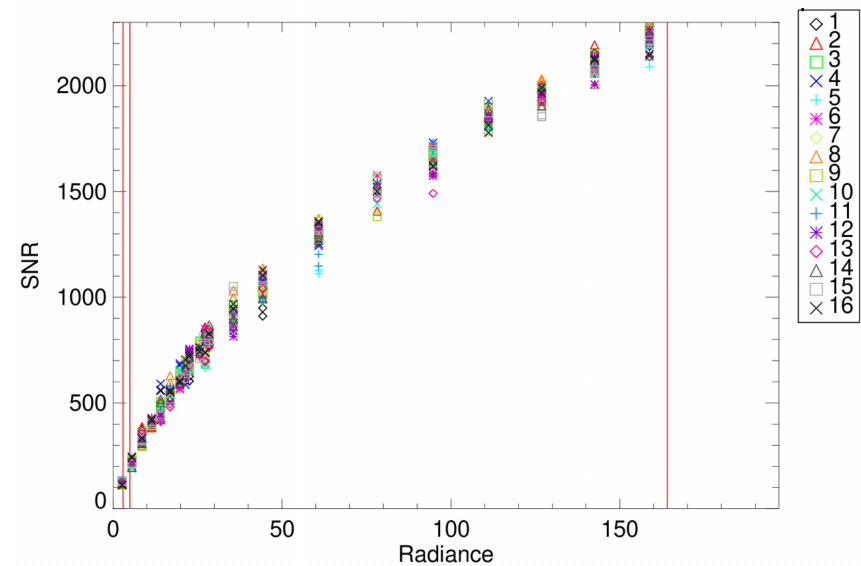
Figure 6. The signal-to-noise ratio (SNR) of band M8 for all detectors (colored symbols) as a function of SIS100 radiance (W/m 2 / µ m/sr). The three vertical red lines are for Lmin (left), Ltyp (middle) and Lmax (right).